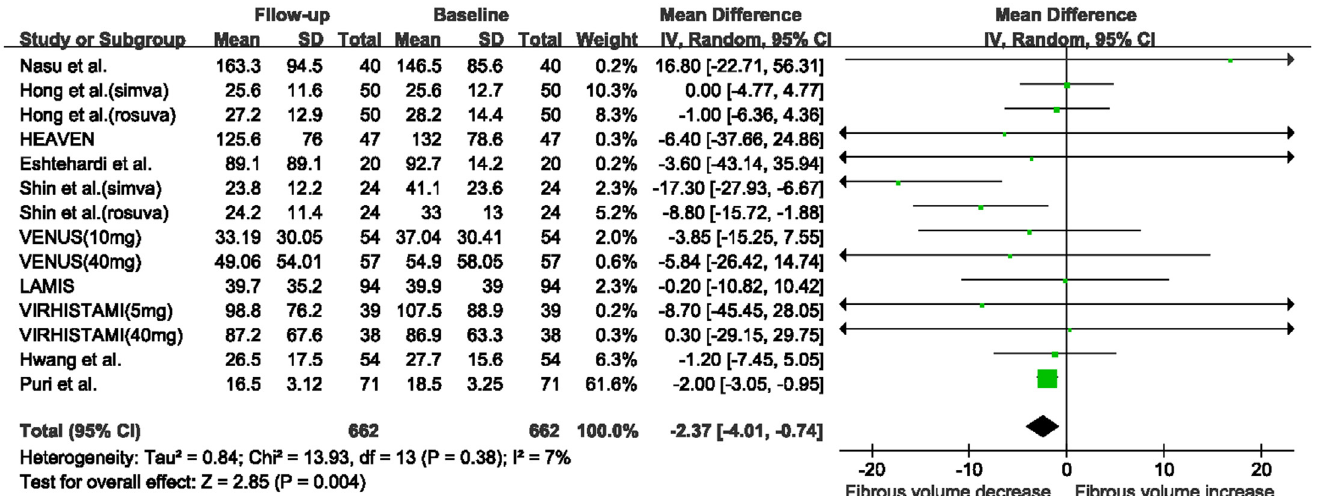
Fig 2. Changes in fibrous volume between follow-up and baseline with statin therapy. Abbreviations: CI: confidence interval; SD: standard deviation.